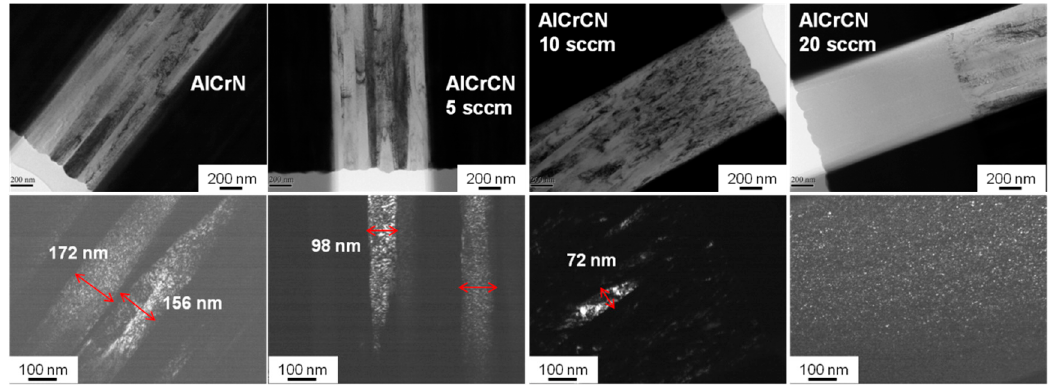
Figure 4. BF and DF TEM images of AlCrN and AlCrCN films.